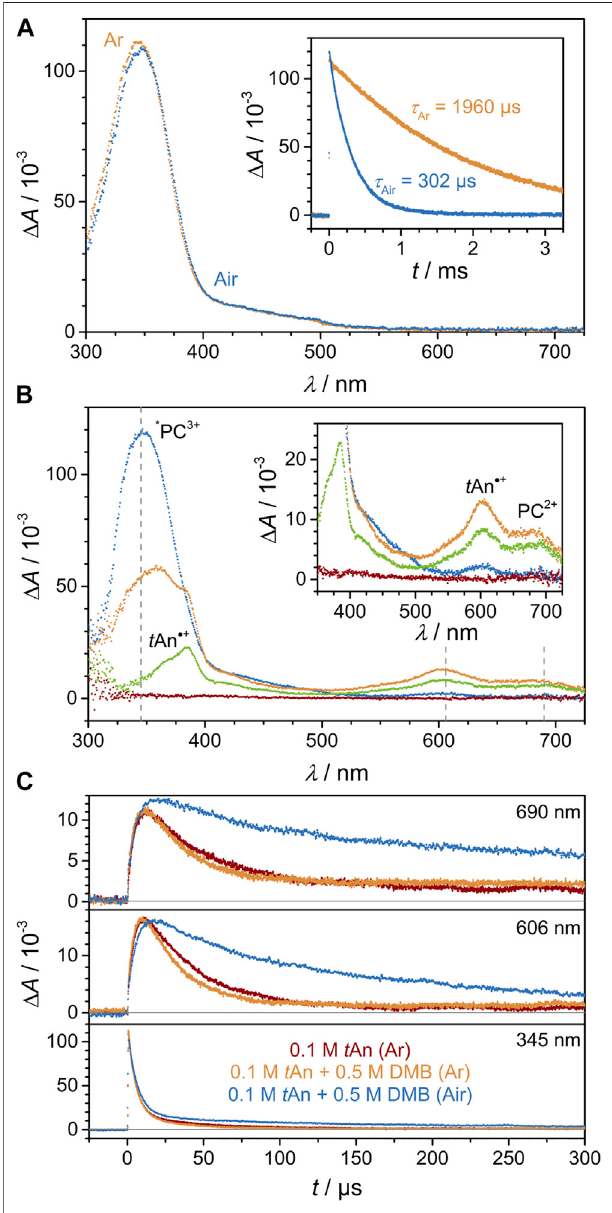
FIGURE 3 | LFP investigations on pure and quenched solutions of [Cr(tpe) (A) Transient absorption spectra of an air-saturated (blue) and a deaerated (orange) [Cr(tpe) 2 ][BF 4 ] 3 solution at a time delay of 50 ns. Inset, corresponding decay traces at 345 nm. (B) Transient absorption spectra monitored 50 ns (blue), 5 µs (orange), 50 µs (green) and 500 µs (red) after laser excitation of a